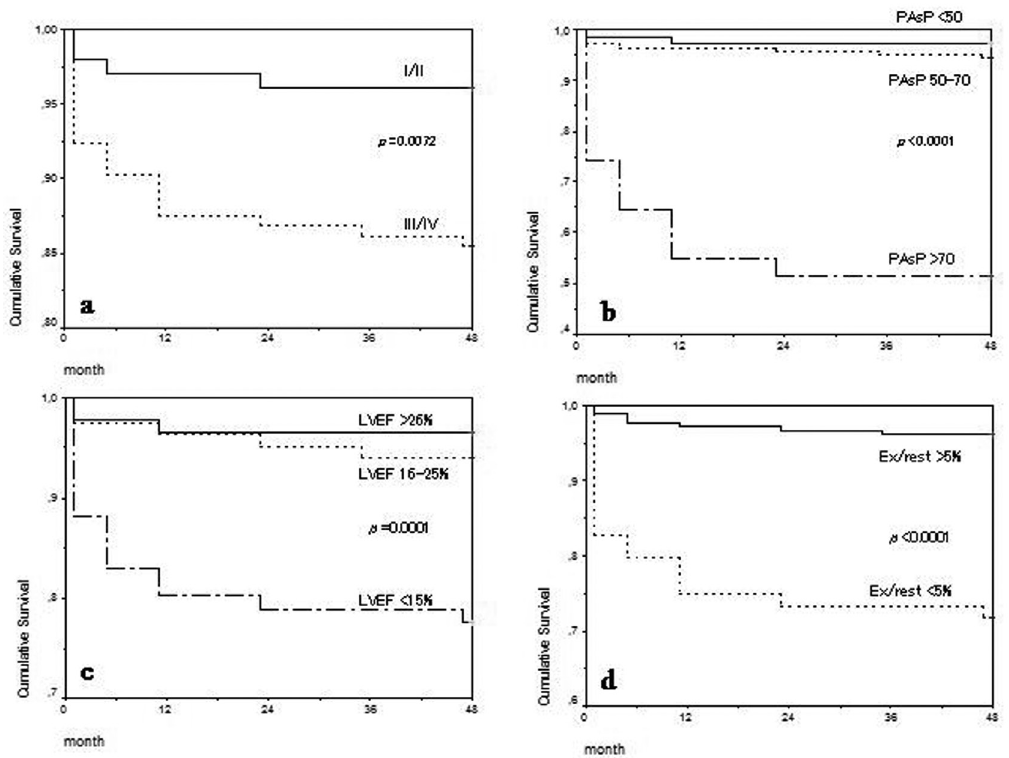
Figure 1 - Kaplan-Meier cumulative survival curves adjusted for: (a) NYHA FCCHF; (b) PasP (mmHg); (c) LVEF; (d) GATED LVEF